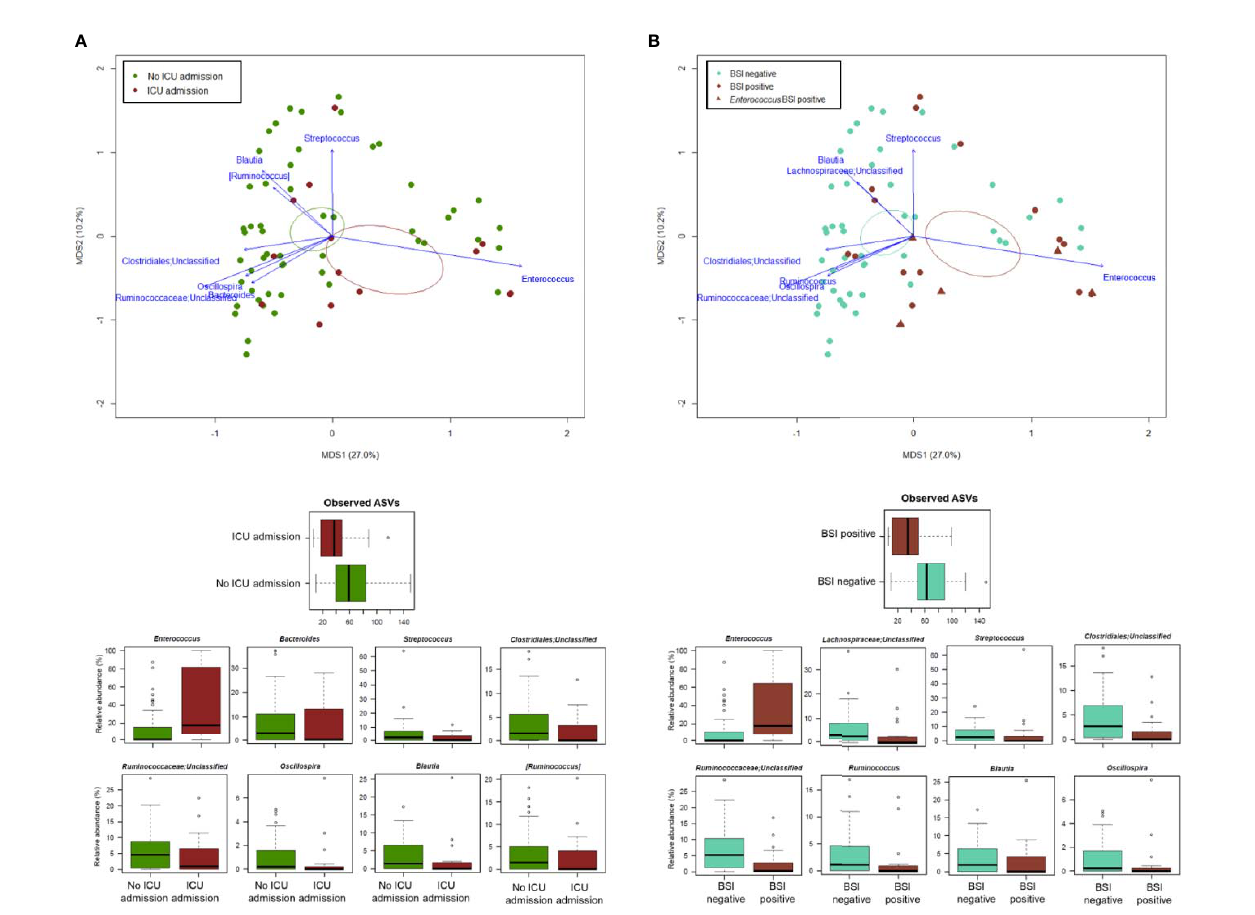
FIGURE 4 | The gut microbiota dysbiosis of COVID-19 patients is exacerbated by ICU admission and development of BSI. Top, Principal Coordinates Analysis (PCoA) based on Bray-Curtis dissimilarity between the microbiota pro fi les of COVID-19 patients, strati fi ed by ICU admission (A) and occurrence of BSI (B) . A signi fi cant separation was found for both variables (p value ≤ 0.05, permutation test with pseudo-F ratio). Ellipses include 95% con fi dence area based on the standard error of the weighted average of sample coordinates. Bacterial genera with the largest contribution to the ordination space are indicated with blue arrows (p value ≤ 0.001, permutational correlation test, “ env fi t ” function). Bottom, Boxplots showing the distribution of alpha diversity, estimated according to the number of observed ASVs, and the relative abundance of genera differentially represented between groups ( i.e. , COVID-19 patients admitted or not to the ICU, panel A; COVID-19 patients developing BSI or not, panel B) (p value ≤ 0.05, “ env fi t ”